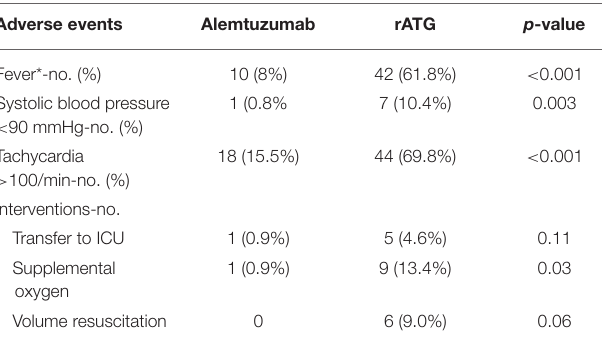
TABLE 4 | Adverse events after therapy with alemtuzumab or